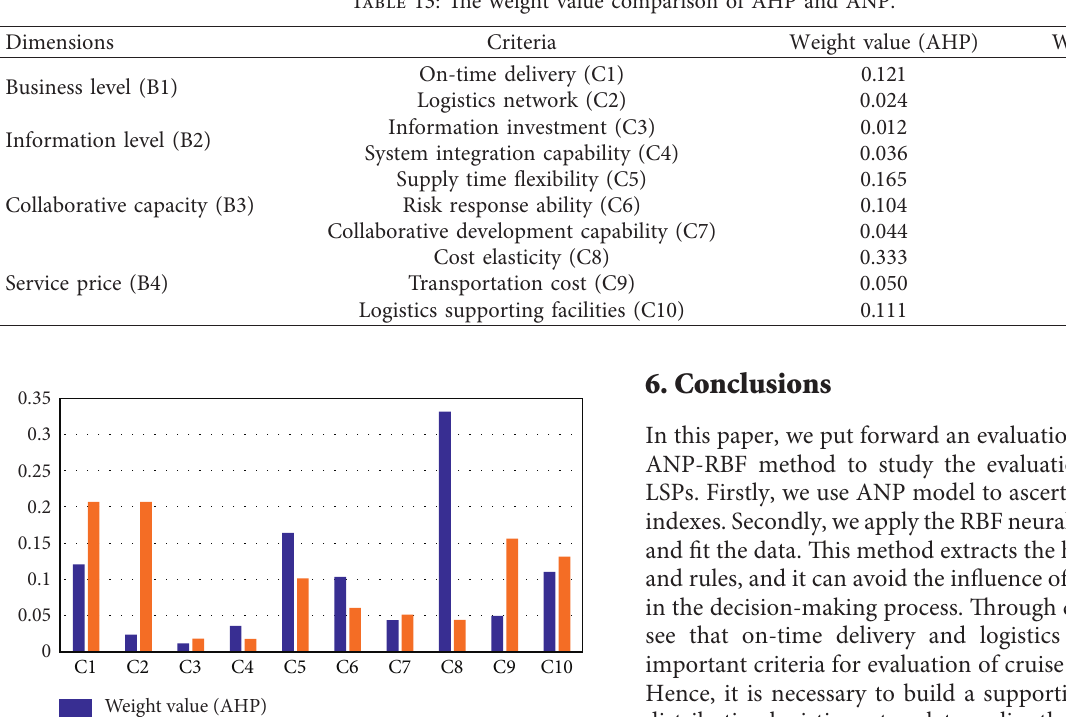
Table 13: The weight value comparison of AHP and ANP.